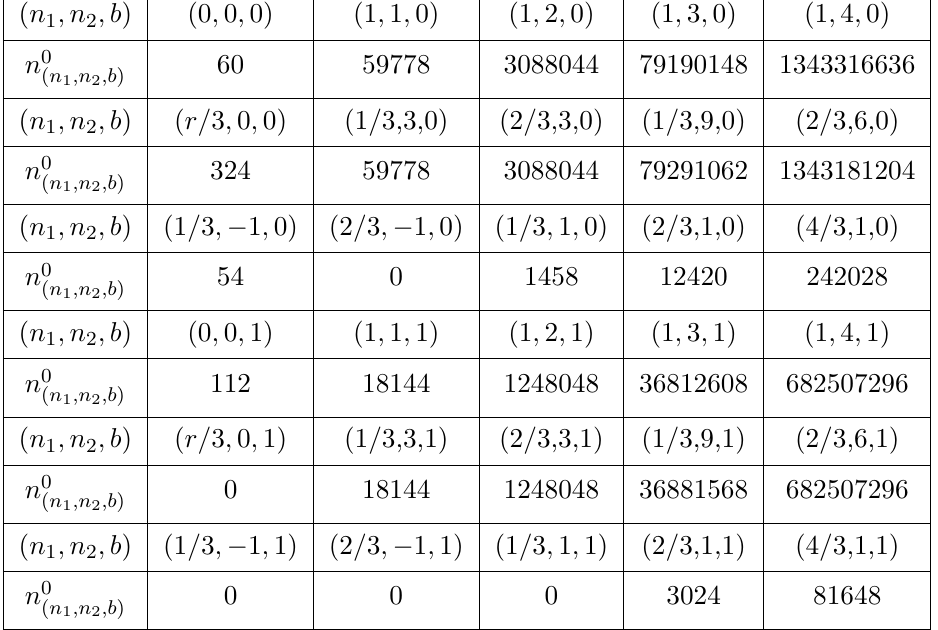
Table 15 . 3 A orbifold, non-standard embedding with single Wilson line. Shift is given by, (cid:13)